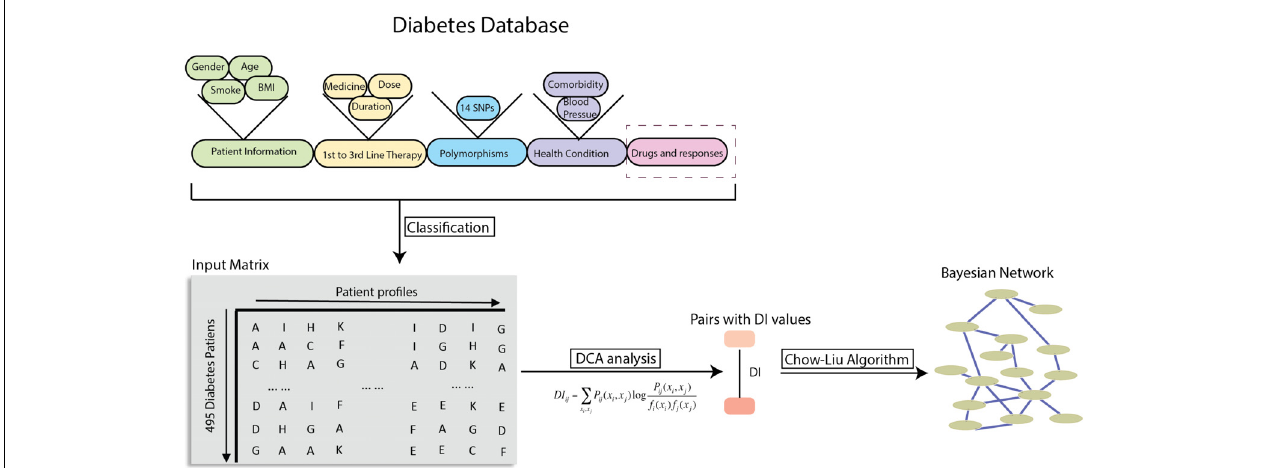
FIGURE 1 | Workflow of global probabilistic modeling on T2DM patient data. Strategy of using T2DM patient datasets to compute the direct information metric between patient genetic or clinical factors and the drug response of OAD treatments. After DI values were calculated, they were used in the Chow-Liu tree for a structural learning for Bayesian